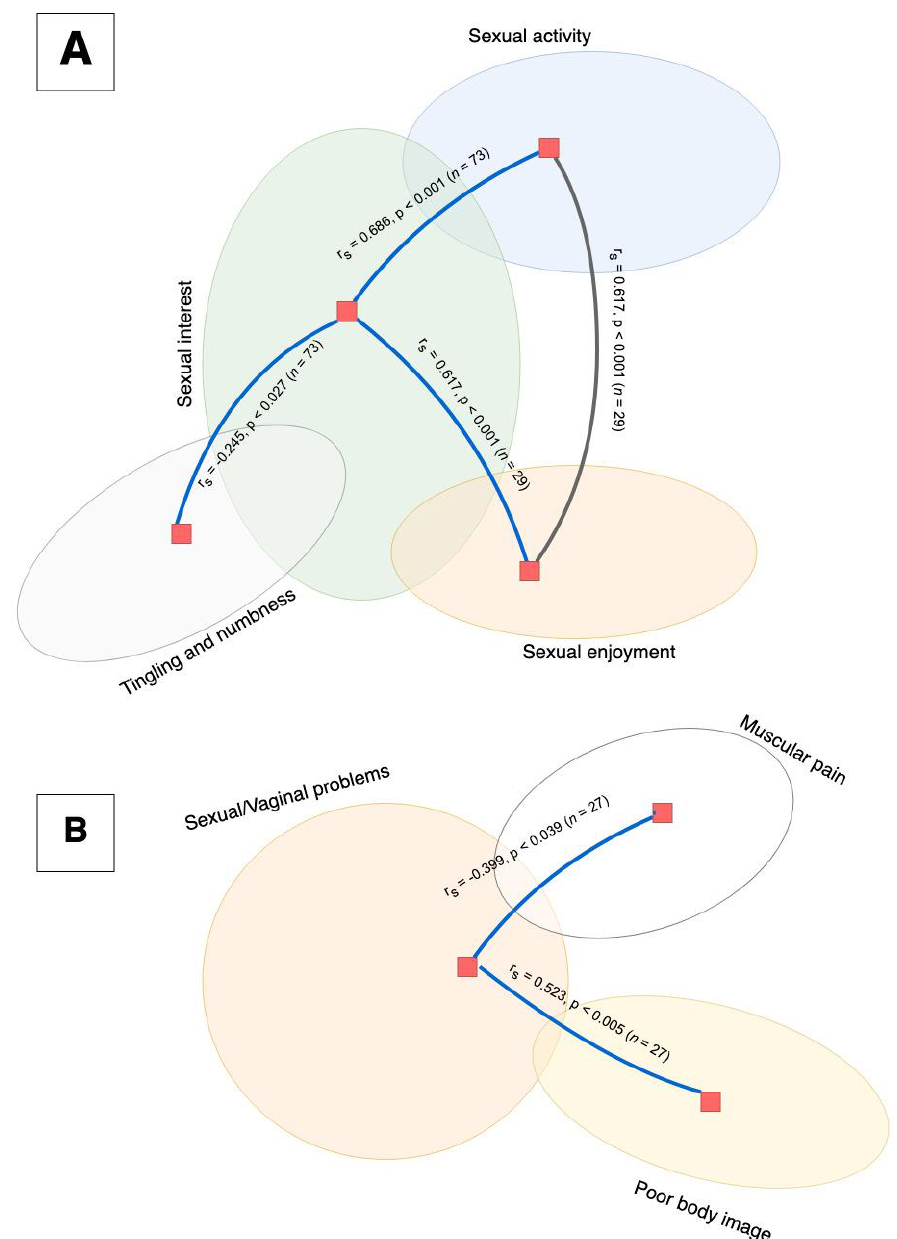
Figure 2. A correlation analysis using Spearman’s Rho showed that the function scale items (depicted in part ( A )) were positively correlated. High reported sexual interest was significantly correlated to sexual activity ( p < 0.001) and sexual enjoyment ( p < 0.001), and was negatively correlated with tingling and numbness symptoms ( p < 0.027). Additionally, there was a significant correlation between sexual enjoyment and activity ( p < 0.001). None of the functional items were correlated with the symptoms of sexual/vaginal problems (depicted in part ( B )). Sexual/vaginal problems were correlated with poor body image ( p < 0.005) and negatively correlated with muscular pain ( p < 0.026).